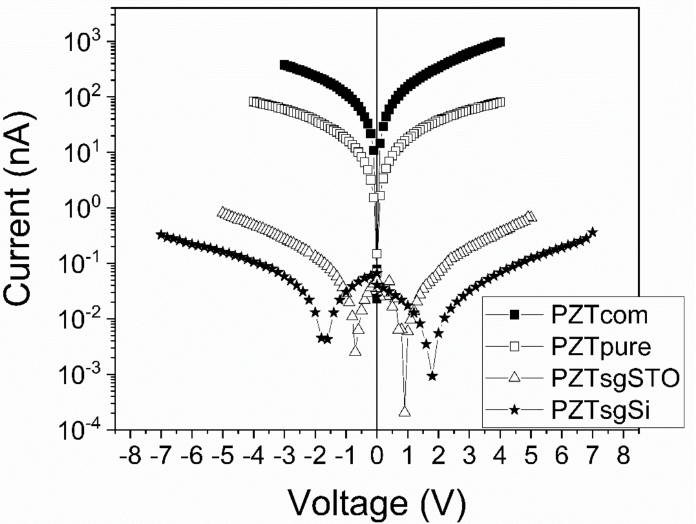
Figure 8. The I-V characteristics for the films investigated in this study: PZT deposited from commercial target (PZT com); PZT deposited from the in-house made, pure target (PZT pure); PZT deposited by sol-gel on STO substrate with bottom SRO electrode (PZT sgSTO); and PZT deposited by sol-gel on an Si substrate with a bottom Pt electrode (PZT